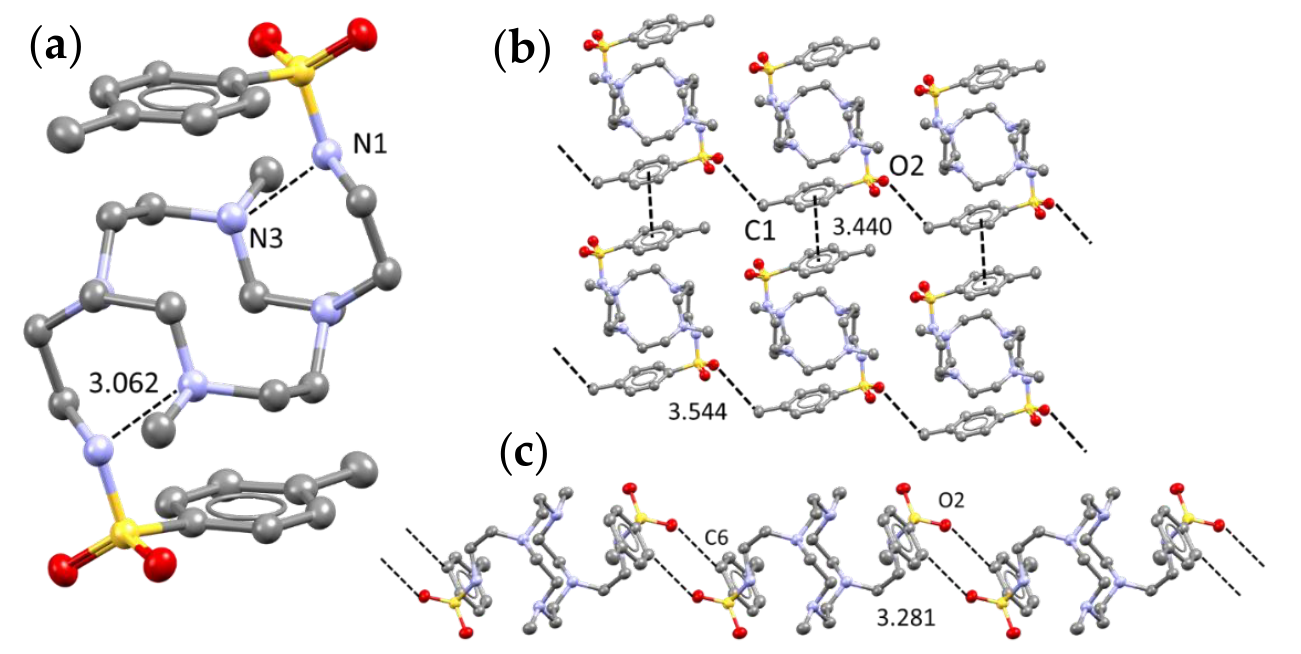
Figure 1. Overview of main interactions as found in L crystal structure; ( a ) intermolecular hydrogen bond; ( b ) π - π stacking and methyl -sulfone contacts; ( c ) double S=O2 ⋯ H-C6 contact. All distances in Å .